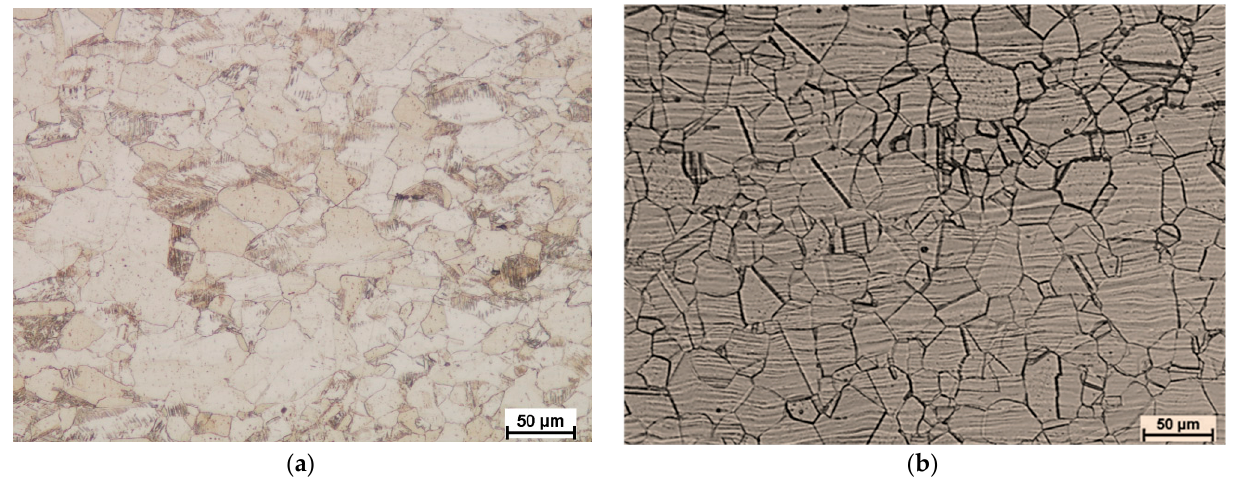
Figure 9. Microstructure of samples taken before rolling ( a ) X2CrNiMo17-12-2 steel ( b ) 10CrMo9-10 steel.